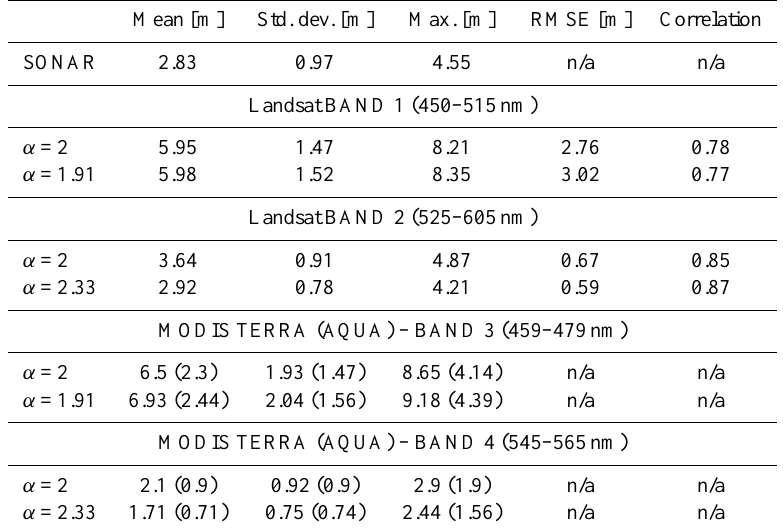
Table 1. Statistics on lake depth retrieval using different space-borne sensors, bands and hypotheses on the value of the α coefficient.